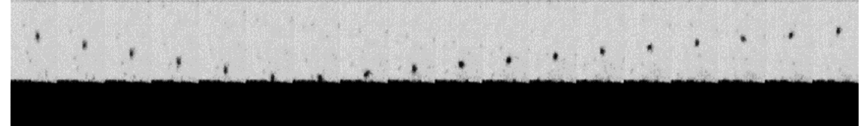
Figure 3. Process of coal ash particles impacting the stainless steel surface in normal direction.